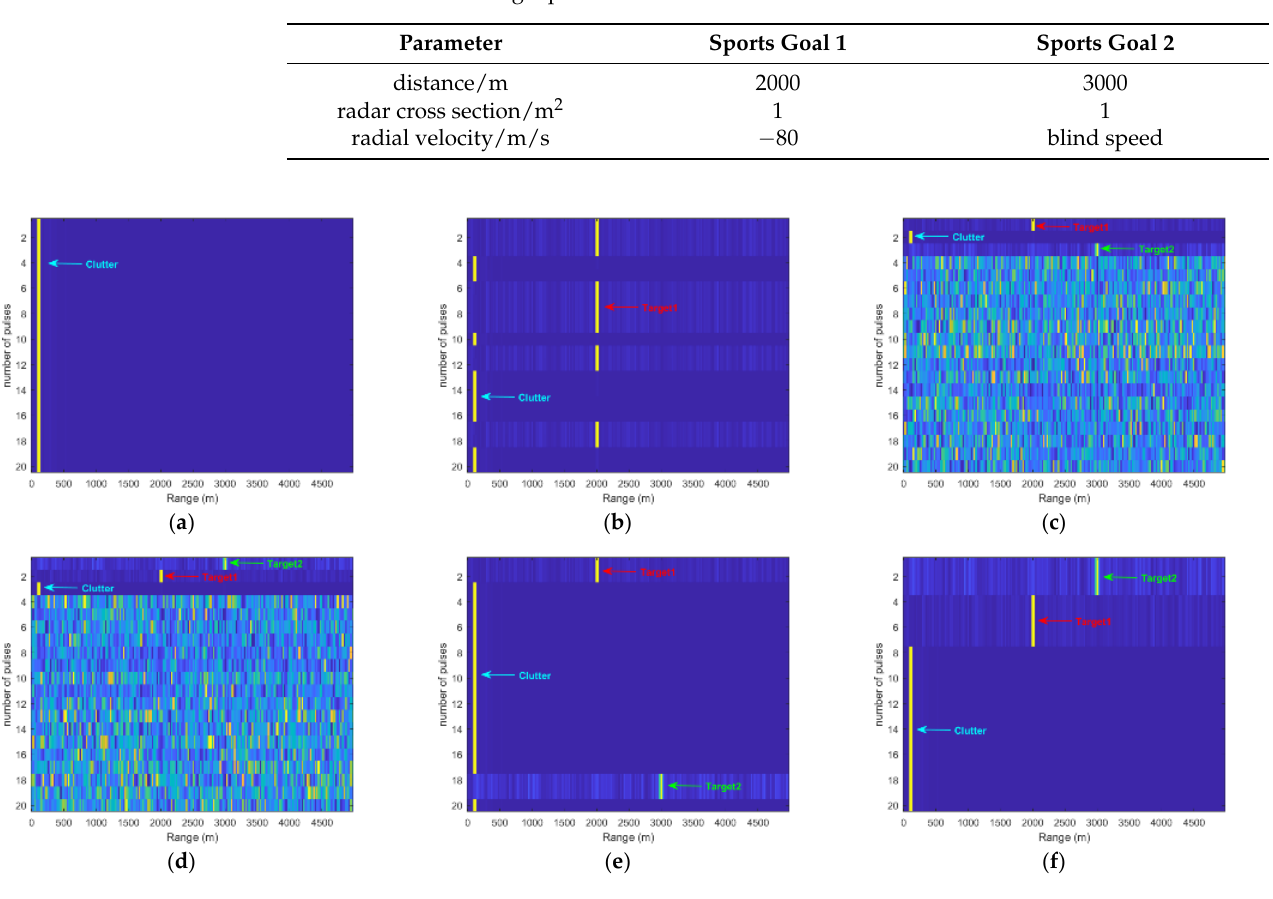
Table 7. Movement target parameters.